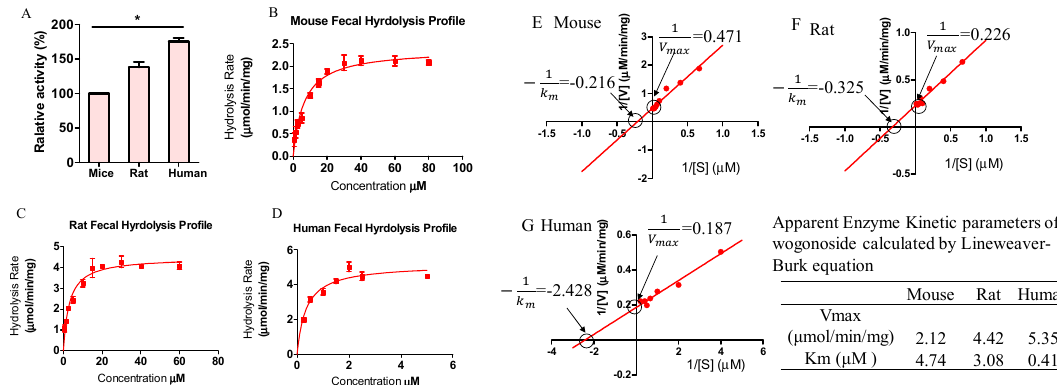
Apparent Enzyme Kinetic parameters of wogonoside calculated by Michaelis–Menten Equation.